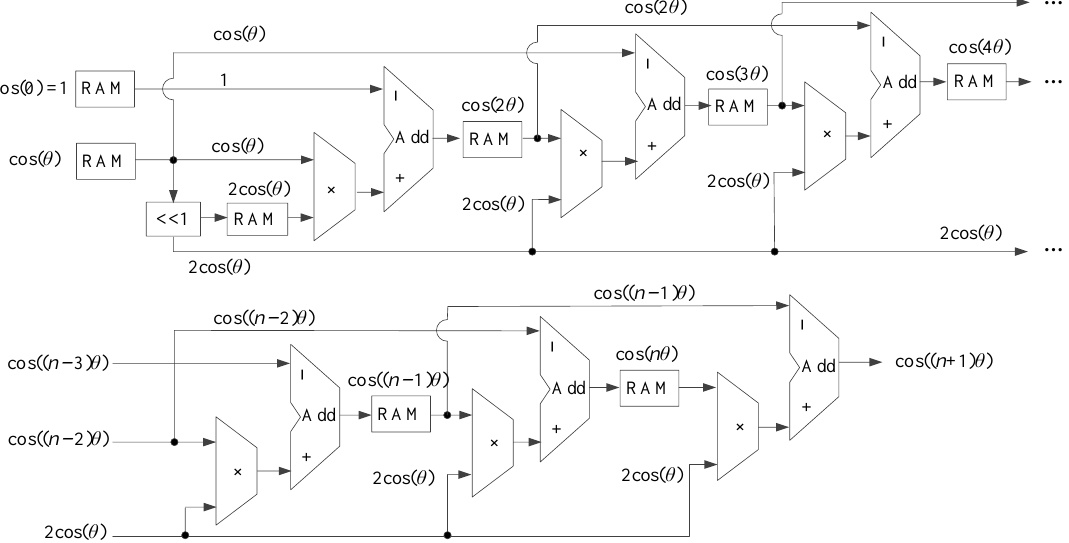
Figure 1. The architecture of the RT algorithm.